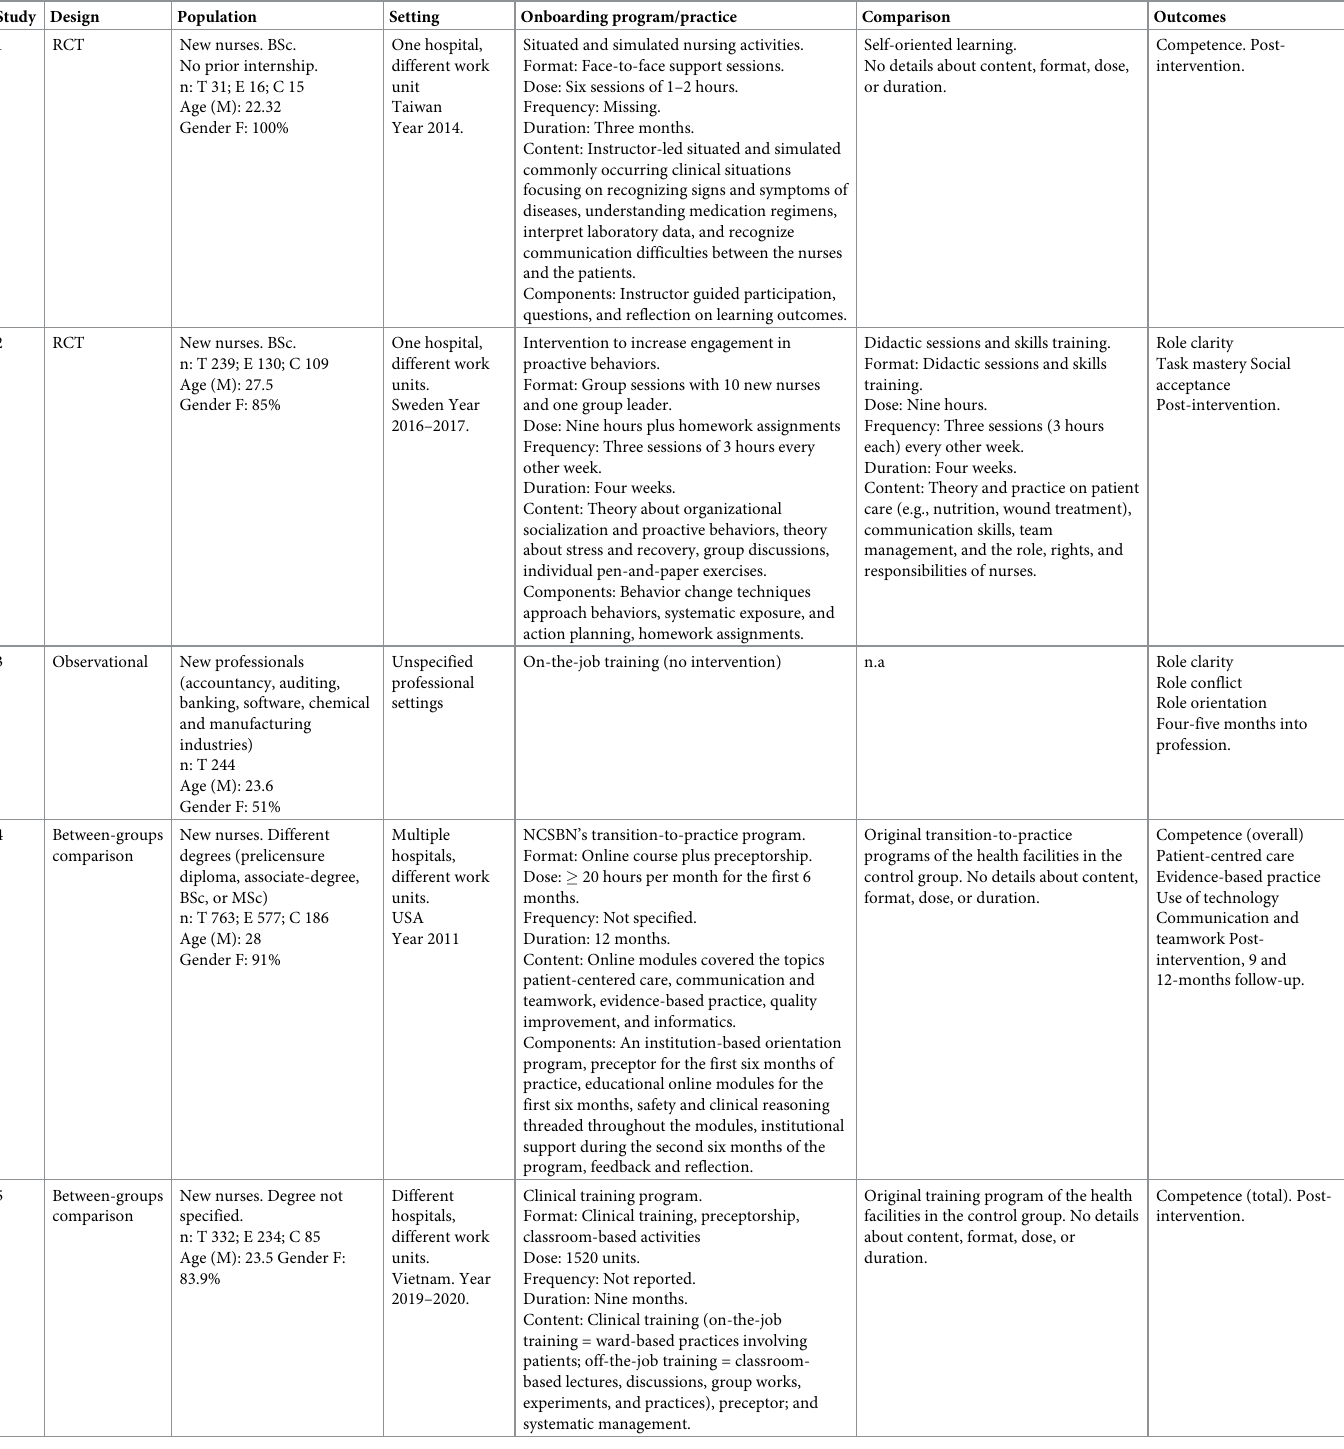
Table 2. Characteristics of included studies. Study